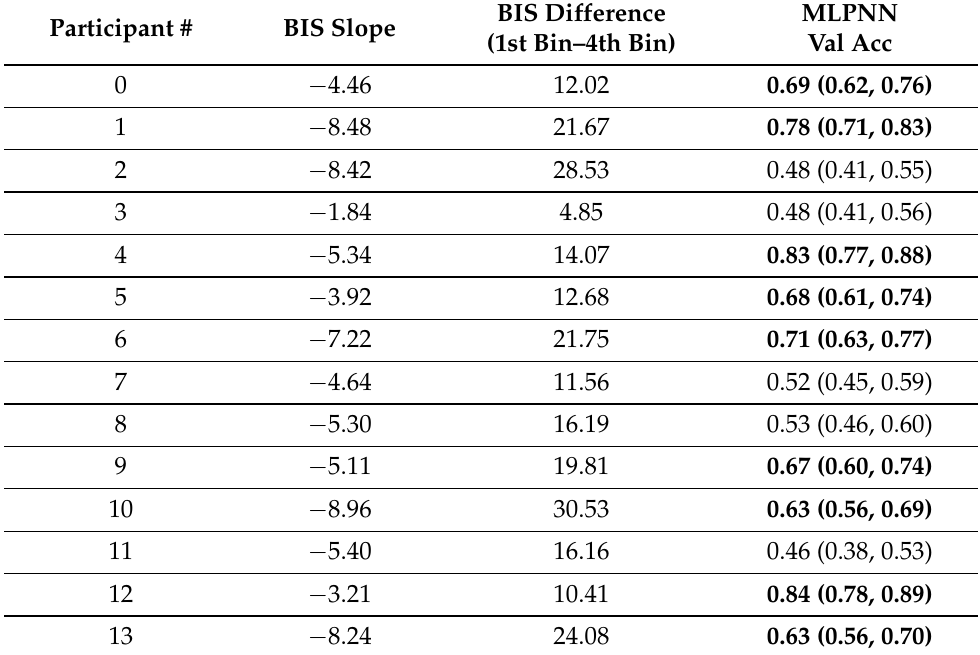
Table 2. This table provides the BIS slope and difference between the BIS measures of first and last bin for the oddball task for each participant. Validation accuracy for the frequency-domain MLPNN model is also provided for each participant. Bold signifies statistical significance of accuracy over random chance (defined as 50% for this binary classification task) as evidenced by the 95% confidence